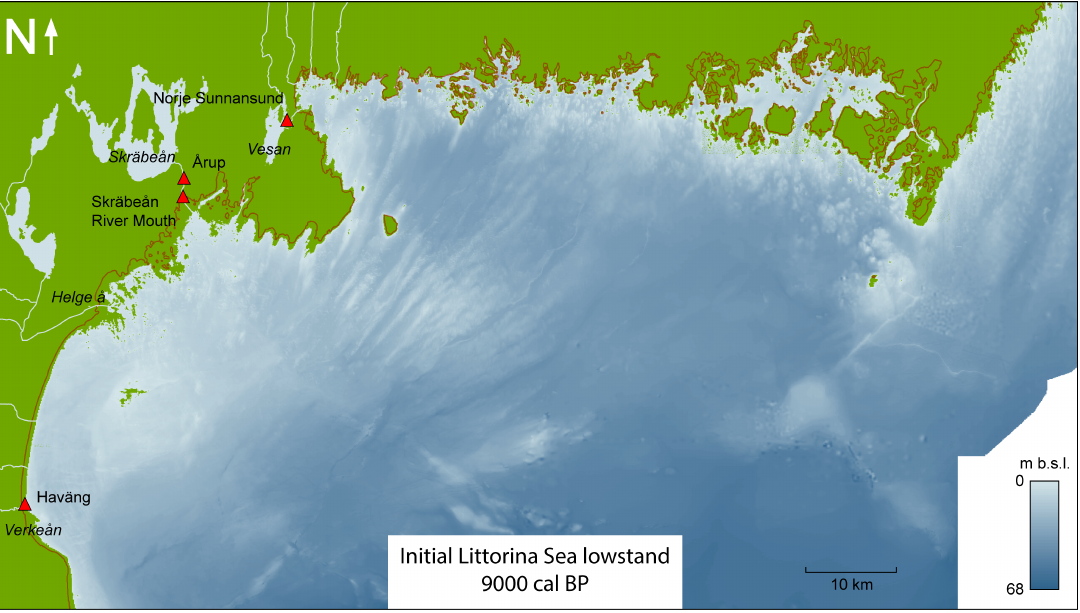
Figure 9. Palaeo-shoreline reconstruction of the study area during the Initial Littorina Sea minimum. The red line represents the present coastline. Red triangles represent the archaeological site discussed in the text. Light blue lines represent rivers discussed in the